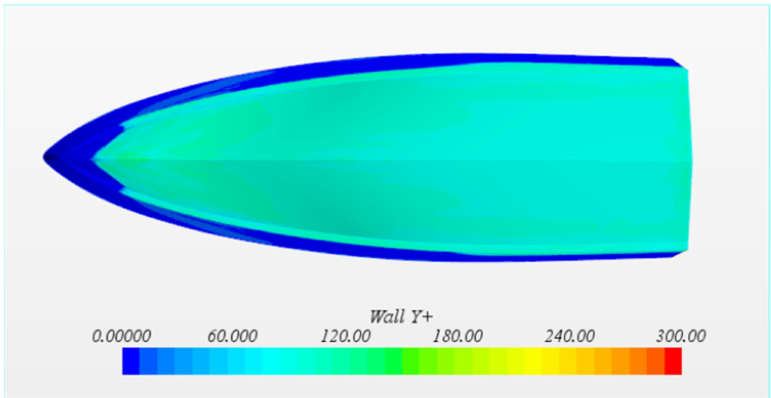
Figure 4. Y+ distribution around the body of the deep-V hull at speed of 4 m/s (corresponding to beam Froude Number of 1.48).